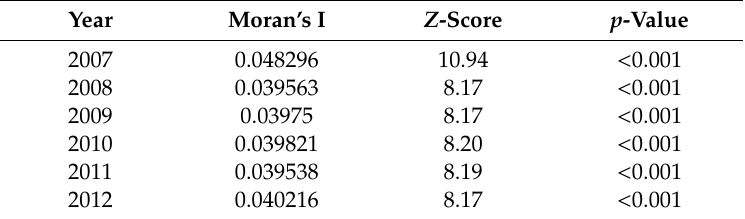
Table 2. Moran’s I index of O. hupensis snail habitat coverage areas (m 2 ) at the administrative village